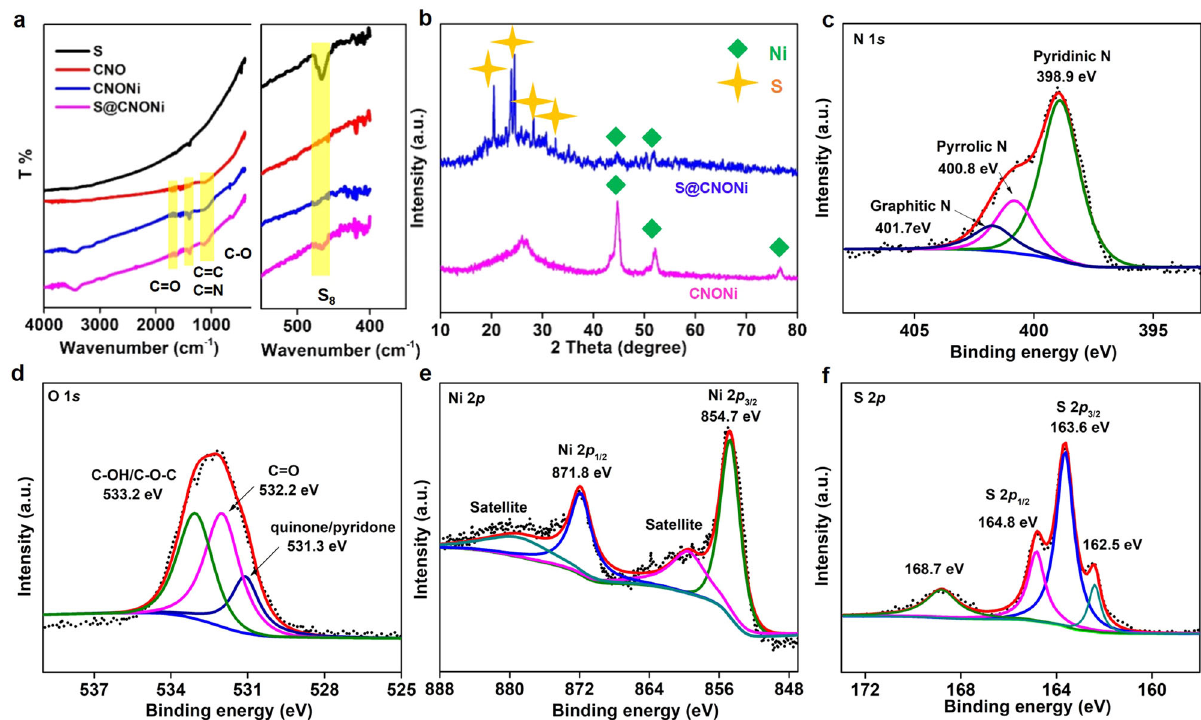
Fig. 2 Chemical characterizations of obtained materials. a FTIR spectra of S, WLC, and WLC-CNTs, and S@WLC-CNTs composites. b XRD patterns of WLC-CNTs and S@WLC-CNTs composites. High-resolution XPS spectra of c N 1 s , d O 1 s , e Ni 2 p , f S 2 p